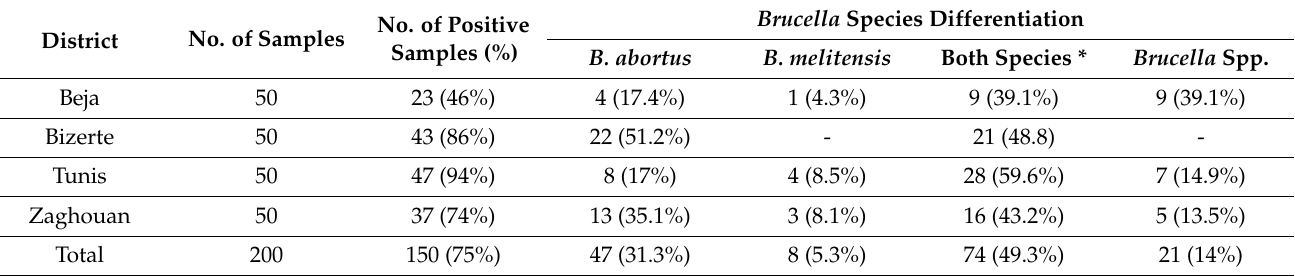
Figure 2. Amplification plot of the real-time PCR data. ( A ): Brucella spp. detection. ( B ): B. abortus and B. melitensis differentiation. Table 2. Contamination rates with B. abortus and B. melitensis